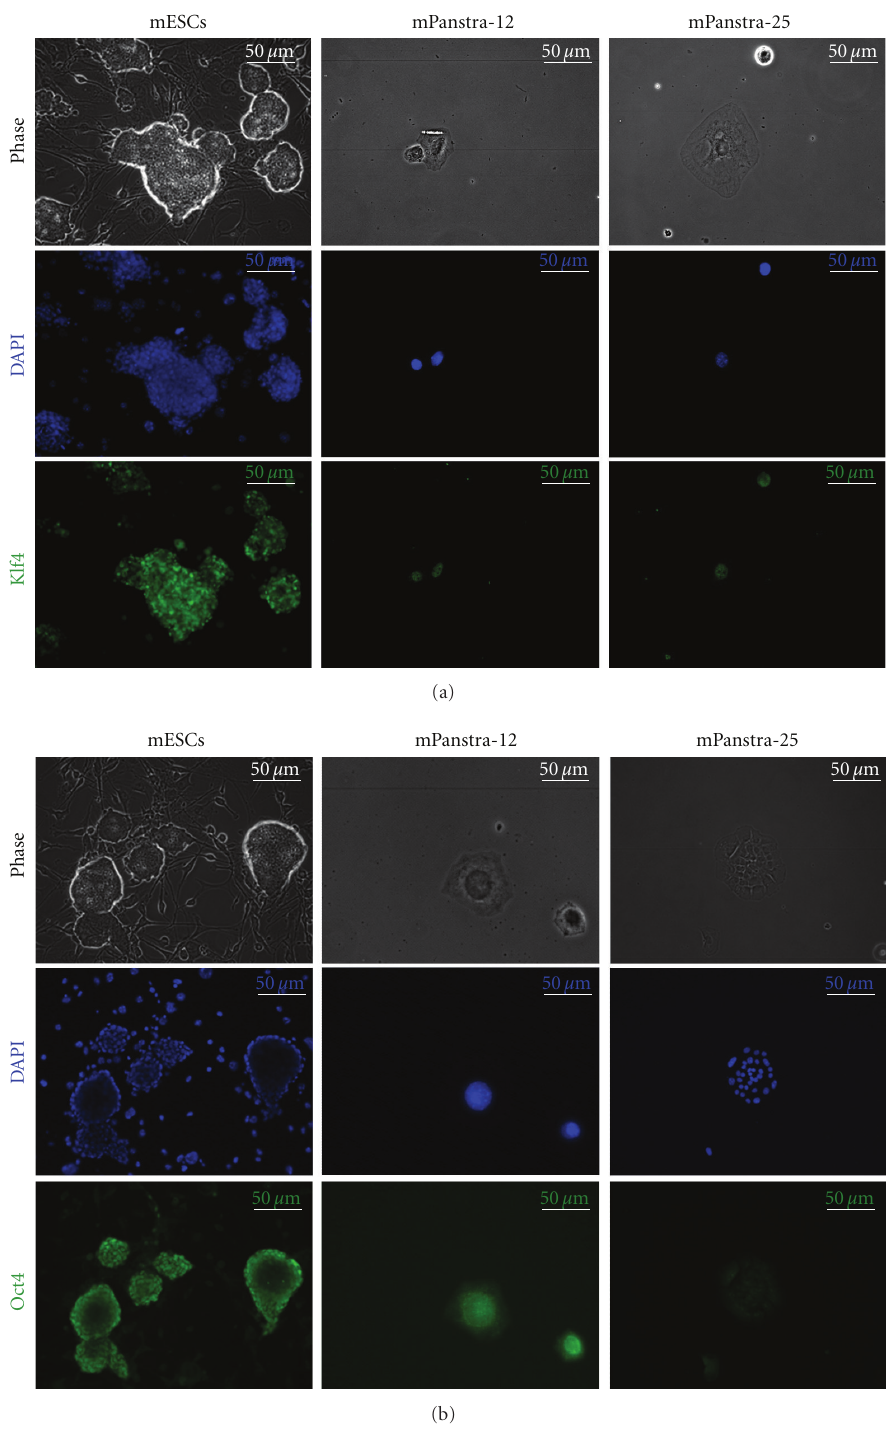
Figure 2: Expression of pluripotency factors in SACK-D mPanstra cells. (a) Nuclear expression of Klf4 was evaluated by indirect in situ immunofluorescence (ISIF) with Klf4-specific antibodies. (b) Nuclear expression of Oct4 was evaluated by ISIF with Oct4-specific antibodies. In each analysis, mouse embryonic stem cells (mESCs) were analyzed as a positive control. DAPI, nuclear DNA